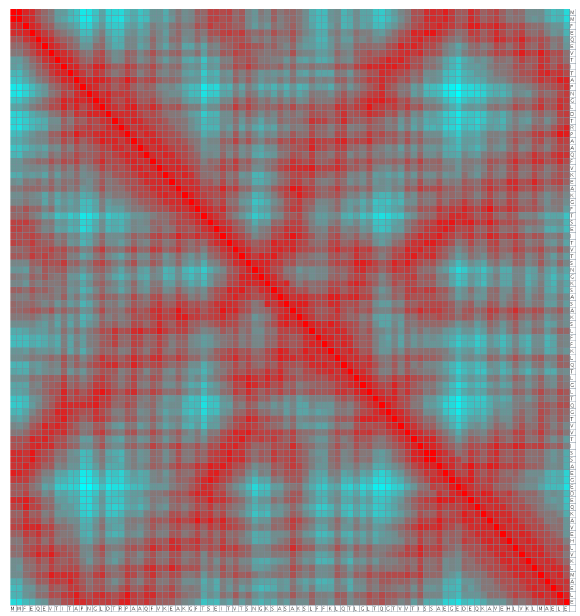
Figure 10: Predicted distance map for the protein 3CCD.